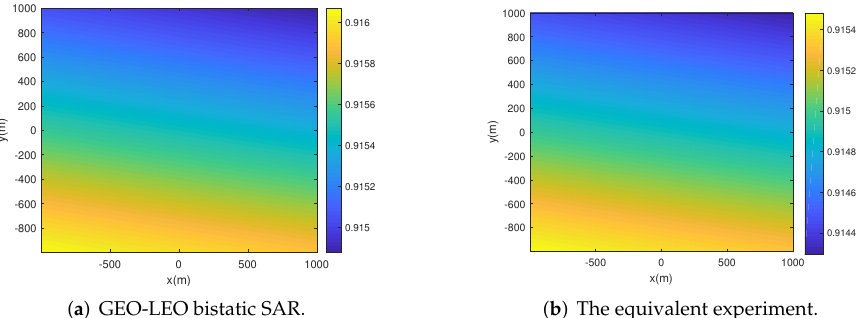
Figure 10. Azimuth resolution of GEO-LEO bistatic SAR and the equivalent